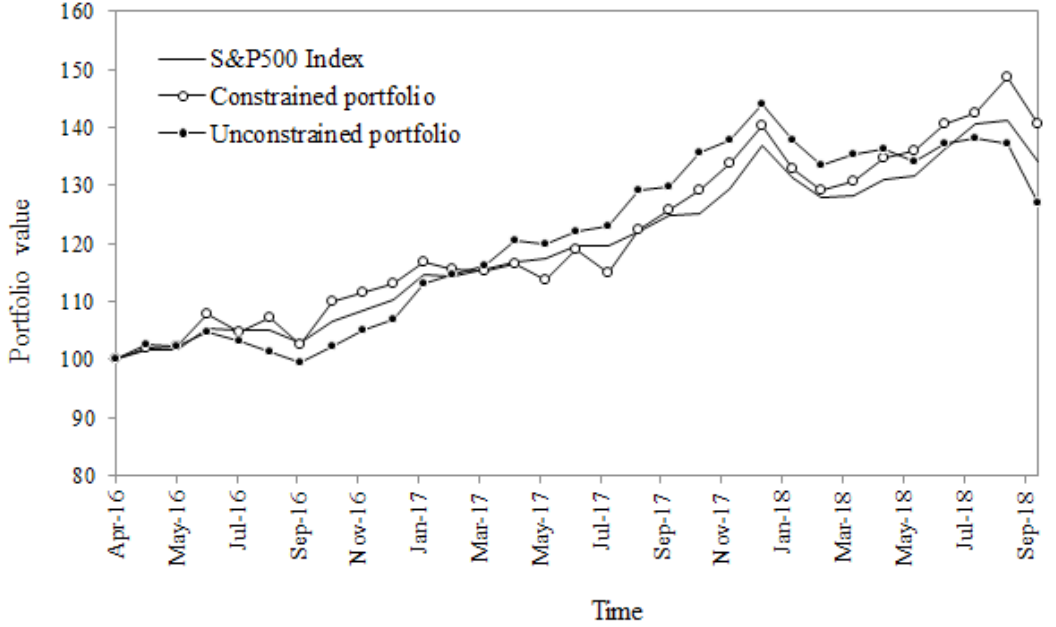
Figure 3. Cumulative monthly portfolio values, obtained by rebalancing the weights ω  and ω ∗ during the out-of-sample